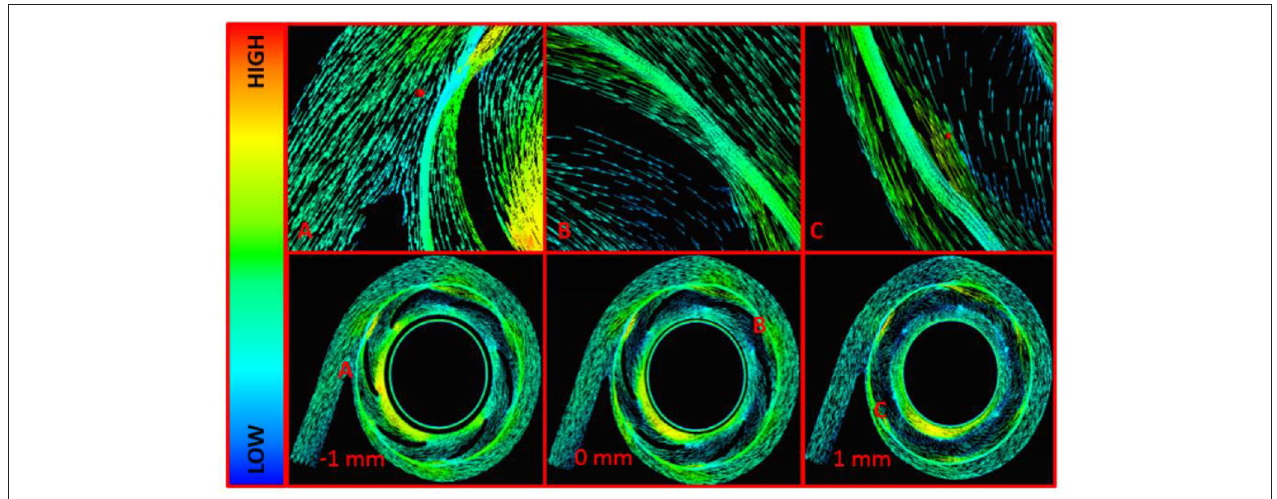
FIGURE 8 | Velocity Vectors for the Centrifugal Pump Model at 3,500 RPM and 3 L/min. (A) Cutwater Region, (B) Impeller Blade Tip, (C) Secondary Flow Path and Impeller Cutwater Region at the Outlet Volute. These are midspan views across the centrifugal blood pump. The central midspan is indicated at 0 mm, and two additional midspan views are shown 1 mm above and -1 mm below the central midspan.